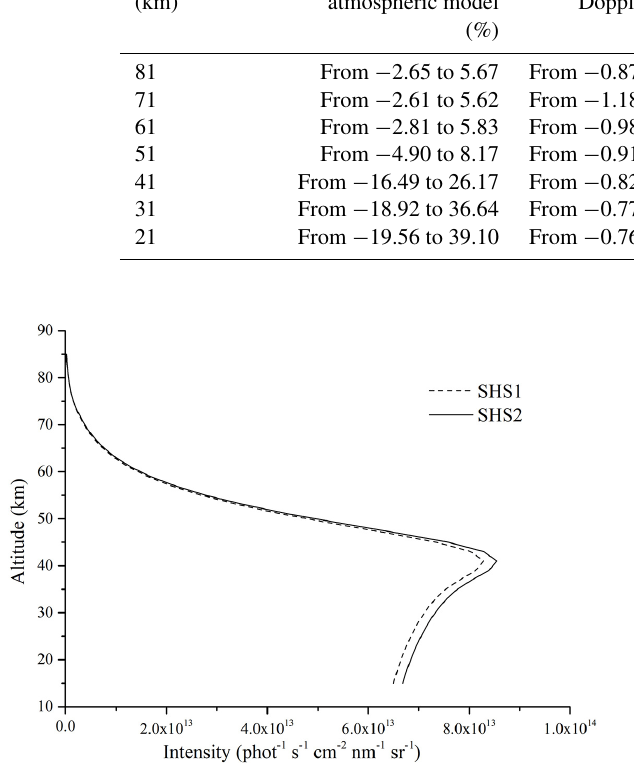
Figure 9. The simulated observation data in the intersection region at the time of T1 and T2. The dashed line is the simulated observa- tion data received by SHS1 at the time of T1, and the solid line is the simulated observation data received by SHS2 at the time of T2.